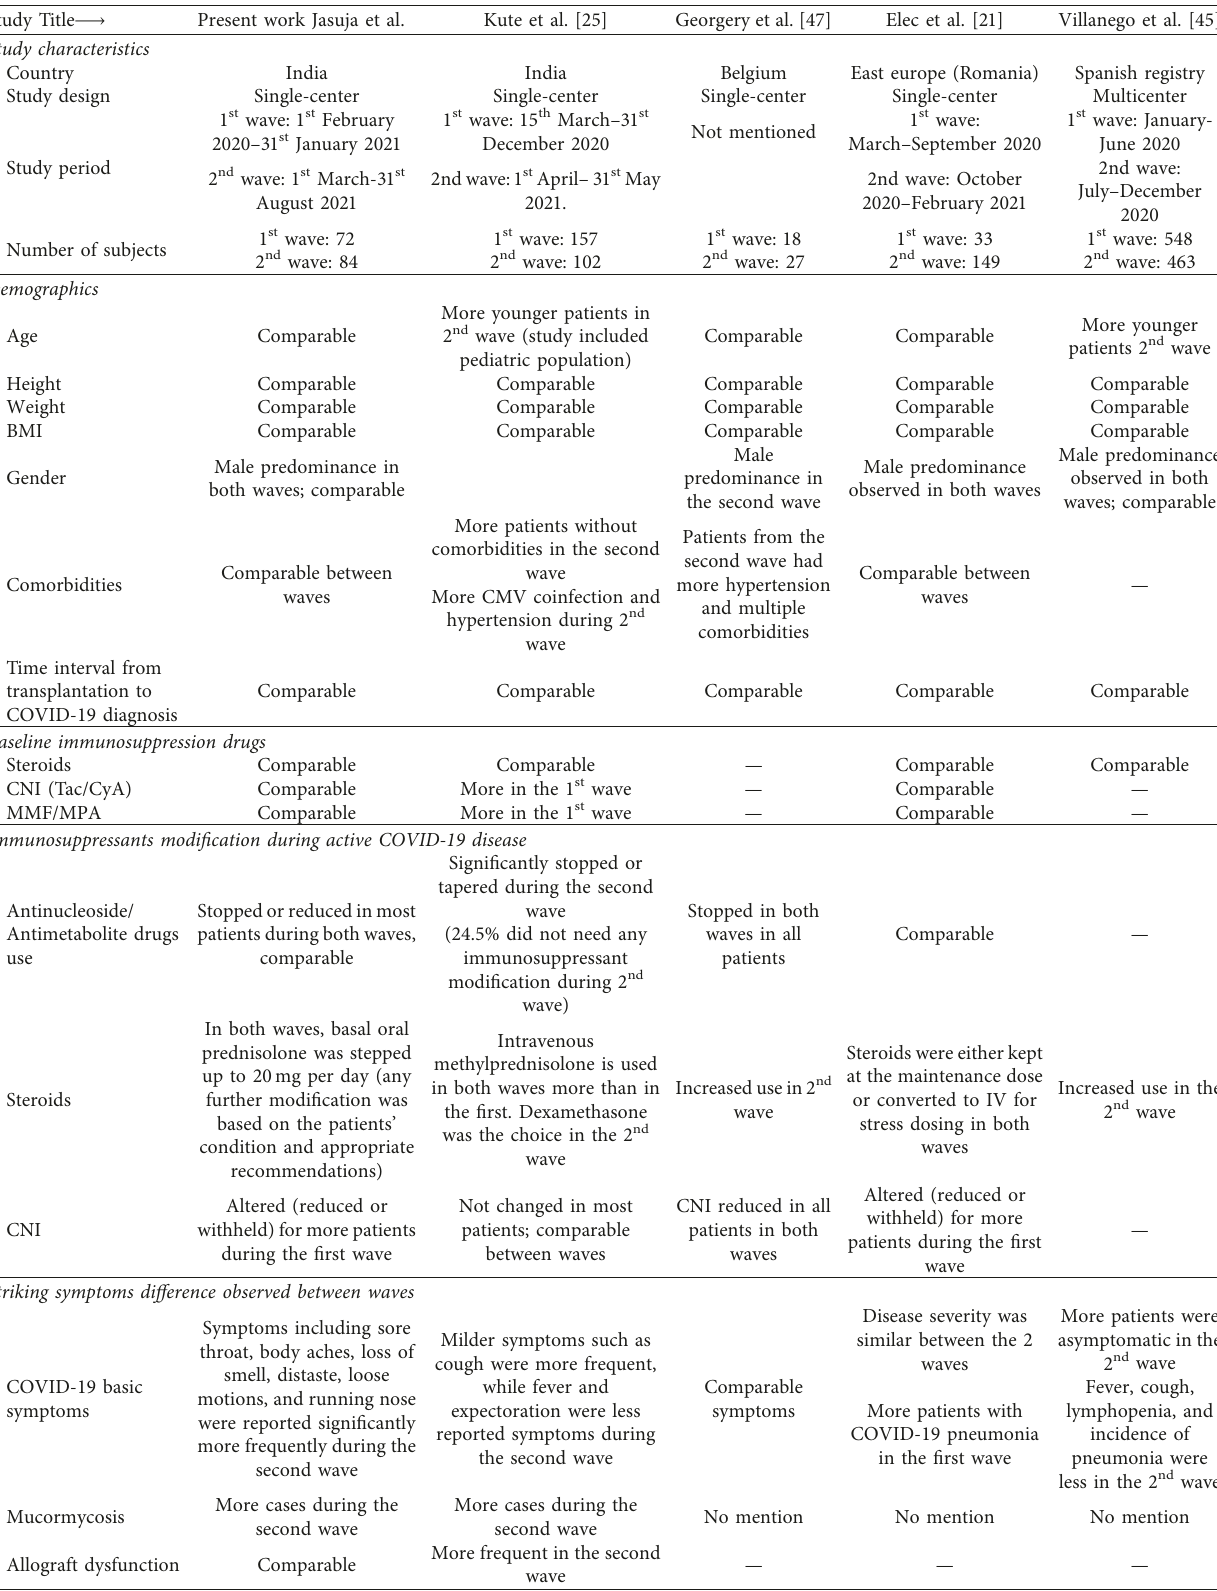
Table 7: Comparison of present work with similar studies conducted in KTRs infected with COVID-19 during the first and second epidemic